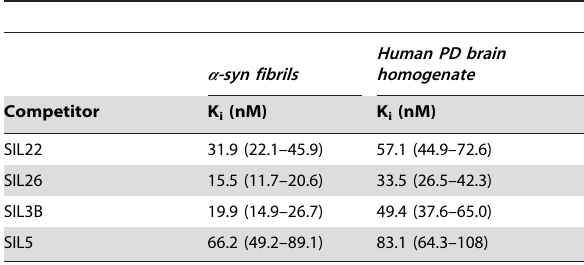
Table 3. Comparison of K i values for SIL analogues in assays with recombinant a -syn fibrils versus human PD tissue.